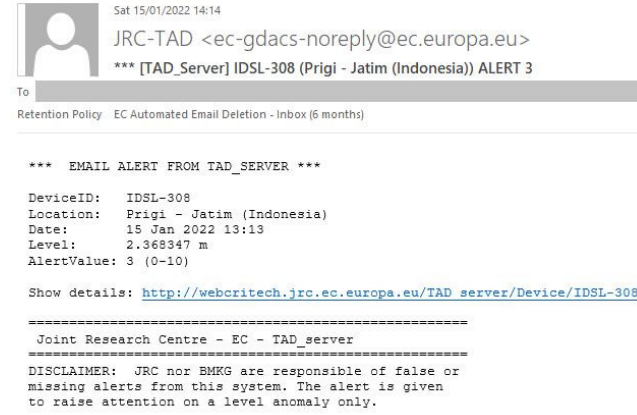
Figure 15. Two snapshots from the IDSL-308 (Prigi, Indonesia) webcams at 13:00:00 UTC, before the arrival of the pressure wave from the Hunga Tonga volcanic eruption at 13:14:24 UTC, as activated by the alerting algorithm. Despite the unfavourable light conditions during the night, it is still pos- sible to note the sudden rise in sea level.